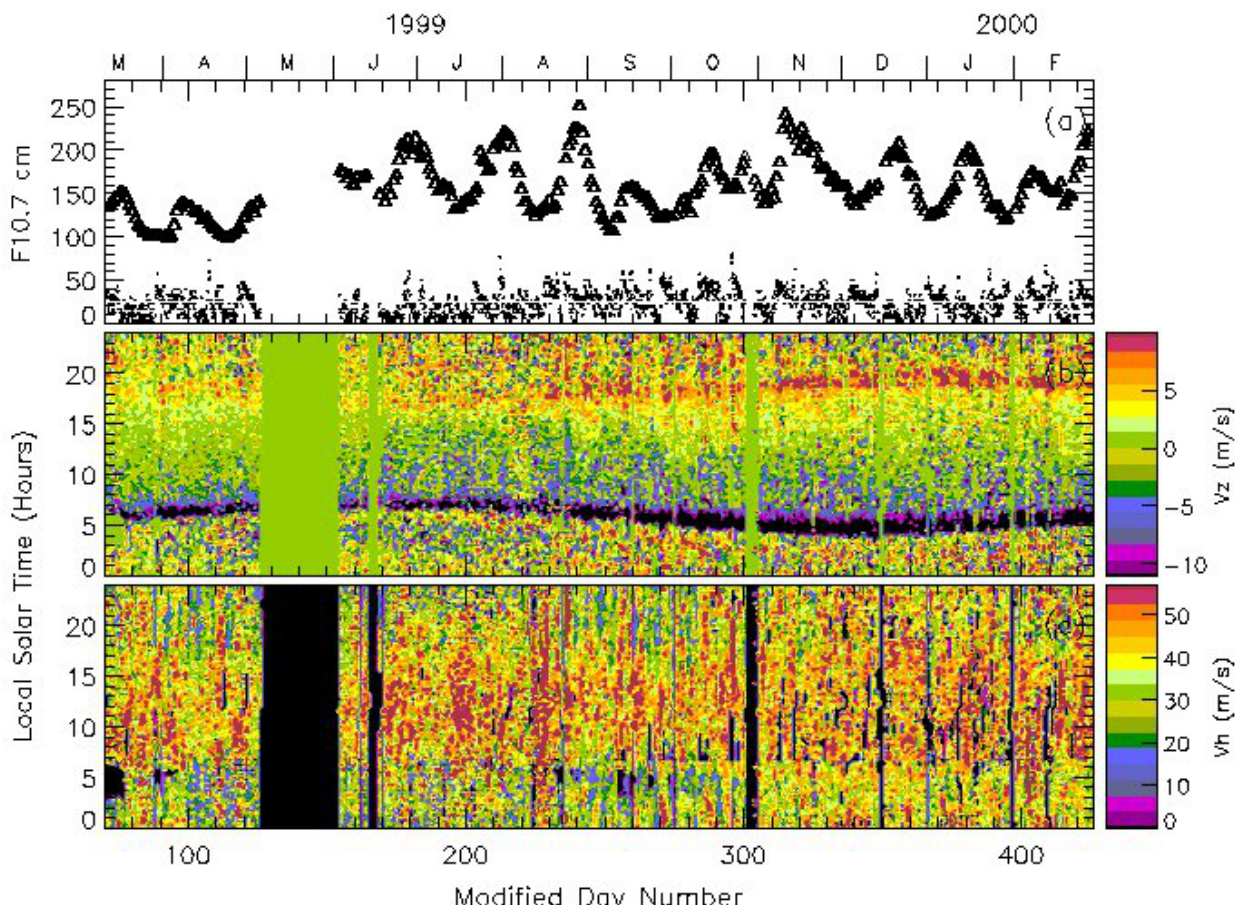
Fig. 1. Summary plot of the database analysed in this paper. (a) Decimetric (10.7-cm) solar flux (triangles) and the Kp index ( × 10) (dots), both versus modified day number with day 1 commencing on 1 January 1999. (b) Contour plot of the vertical component of Doppler-velocity averaged in 15 min bins of LST and 1 day bins of day number. (c) The same as (b) except for the magnitude of the horizontal velocity. Tick marks on the abscissa are at 10 day